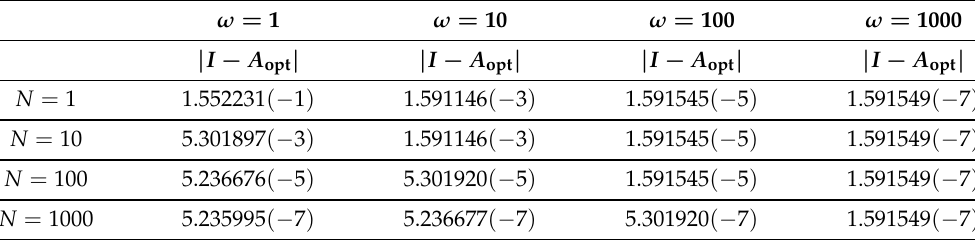
Table 2. The absolute values for the real part of the error (57) of the optimal quadrature formula (56) for N = 1, 10, 100, 1000 and ω = 1, 10, 100, 1000. ω = 1 ω = 10 ω = 100 ω = 1000 | I − A opt | | I − A opt